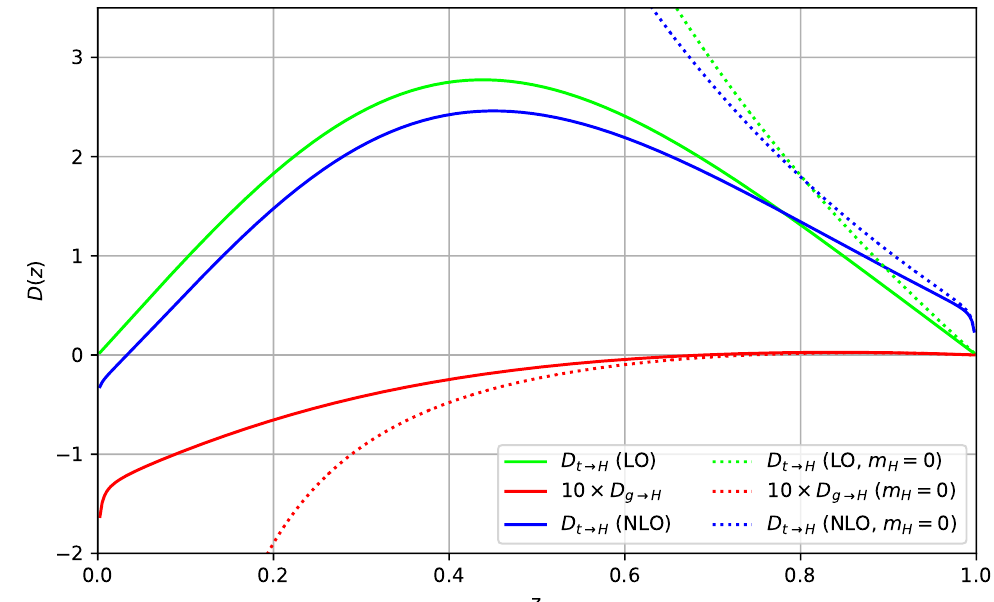
Figure 1. A comparison of the fragmentation functions D g → H (red) and D t → H (blue) at NLO with D (green) at LO. The solid lines correspond to m t → H show the results for m = 0 . In both cases, µ = m H overall factor y 2 / (16 π 2 ) is set to 1 . Note that D g → H has been magnified by a factor of t